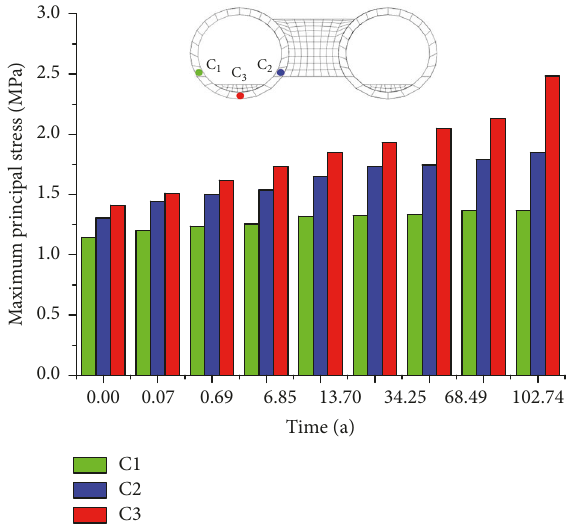
Figure 14: The development trend of tensile damage of the main tunnel